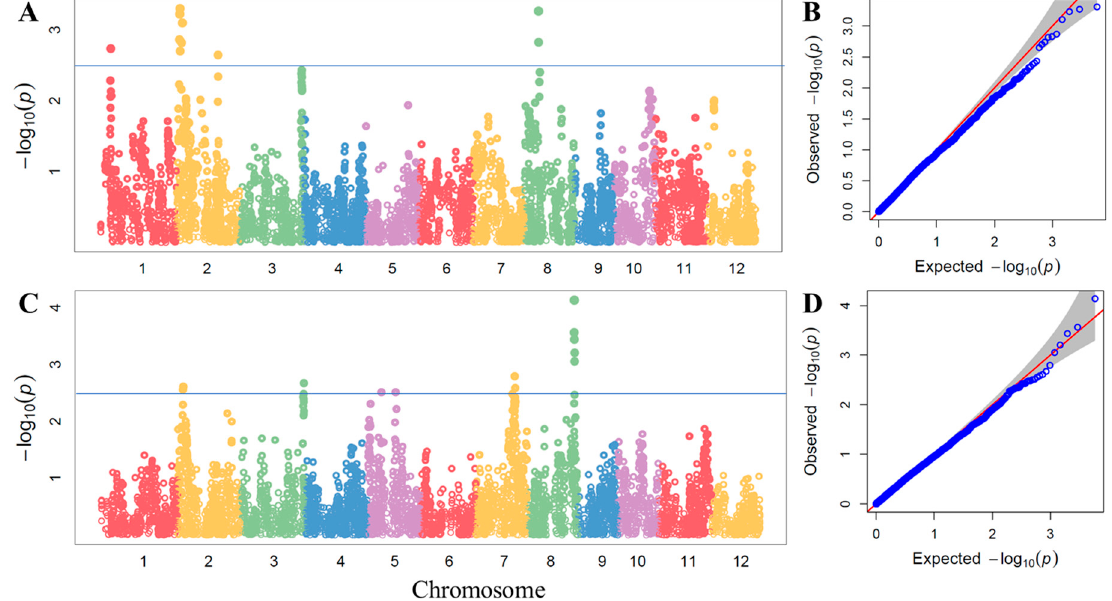
Figure 3. GWAS of Zn 2+ concentration in shoots at the seedling stage and in grains at the mature stage in the MAGIC population. Manhattan and quantile–quantile plots of Zn 2+ concentration in shoots at the seedling stage ( A , B ), and Zn 2+ concentration in brown rice at the mature stage ( C , D ). Table 1. QTLs associated with Zn 2+ concentration in shoots at the seedling stage and grains at the mature stage in the MAGIC population.